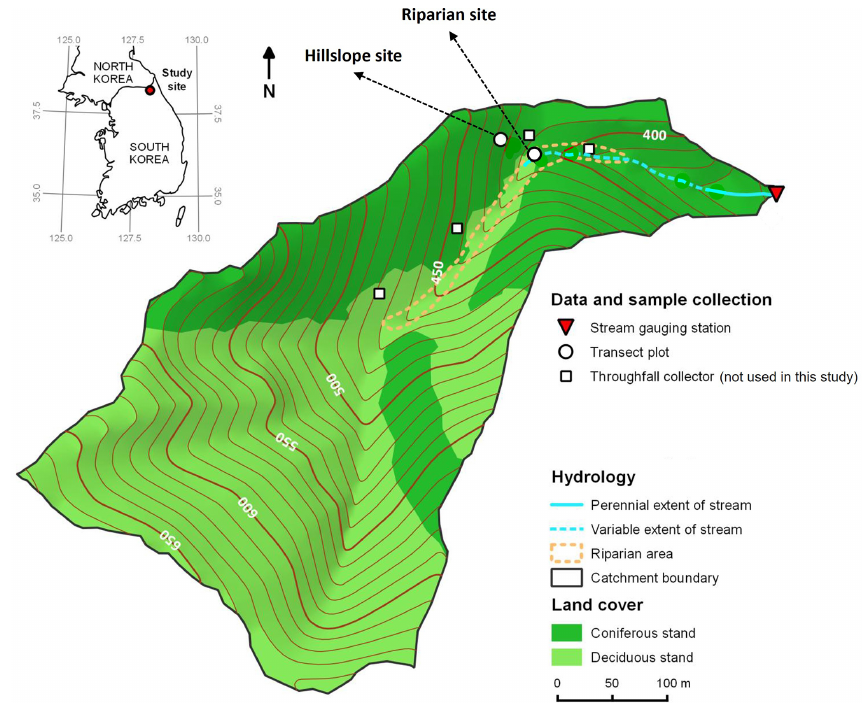
Figure 1. Location and detailed map of the test catchment and sampling setup. Discharge was measured at a V-notch weir installed at the outlet of the catchment (red